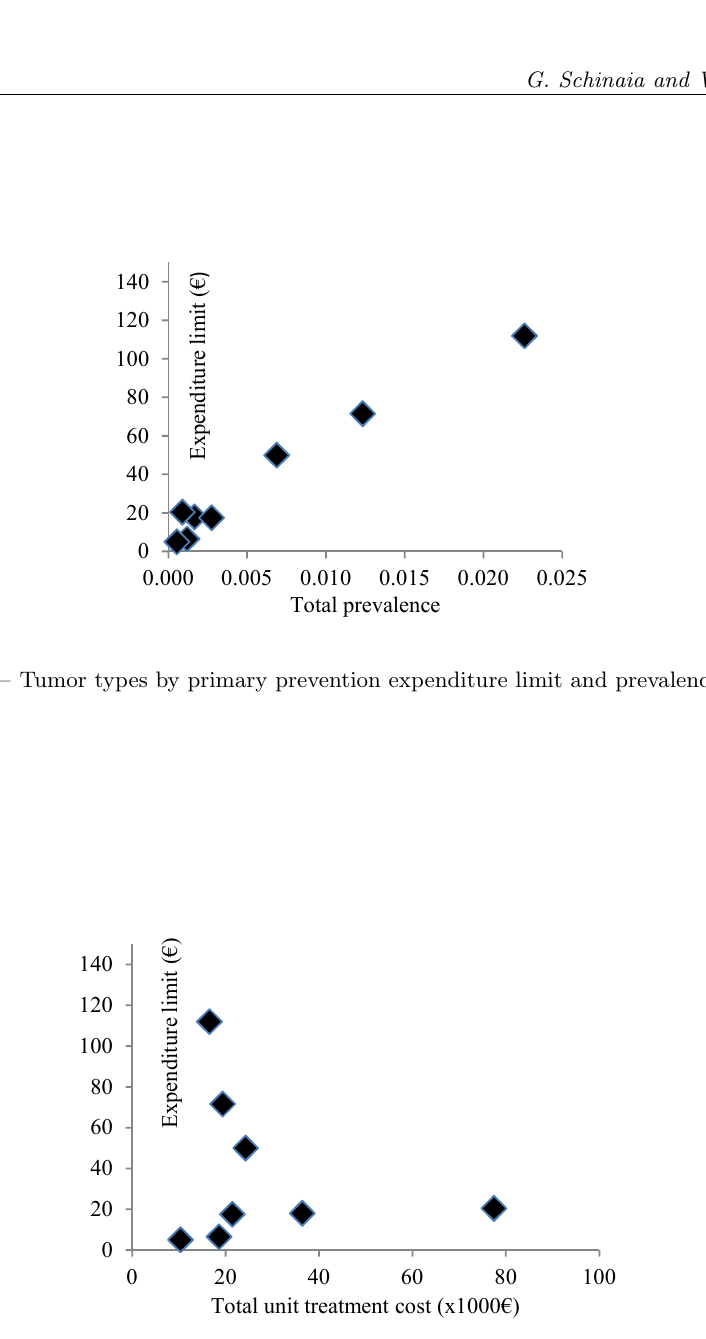
Figure 3 { Tumor types by primary prevention expenditure limit and unit treatment